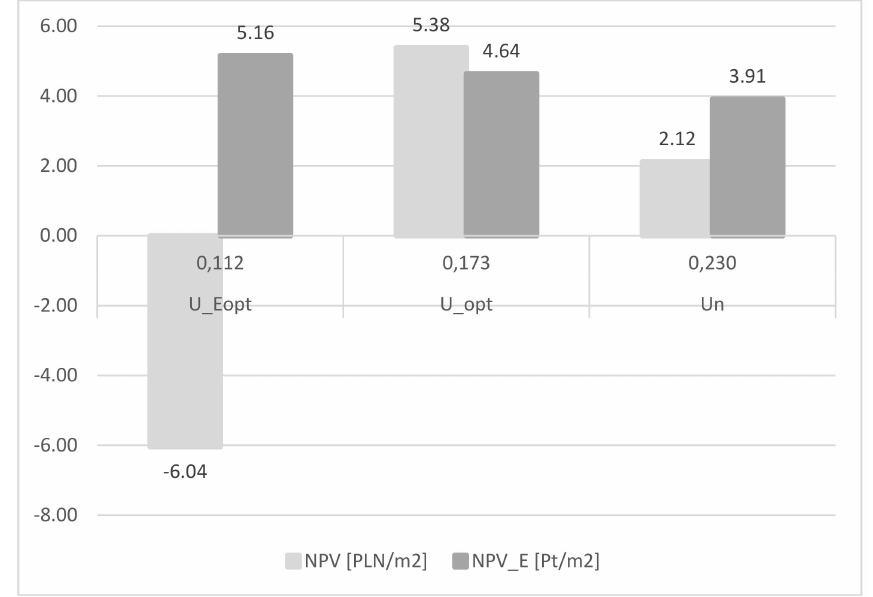
Figure 1. NPV and NPV E values depending on U for variant CC-CGB-MW and climate zone I.